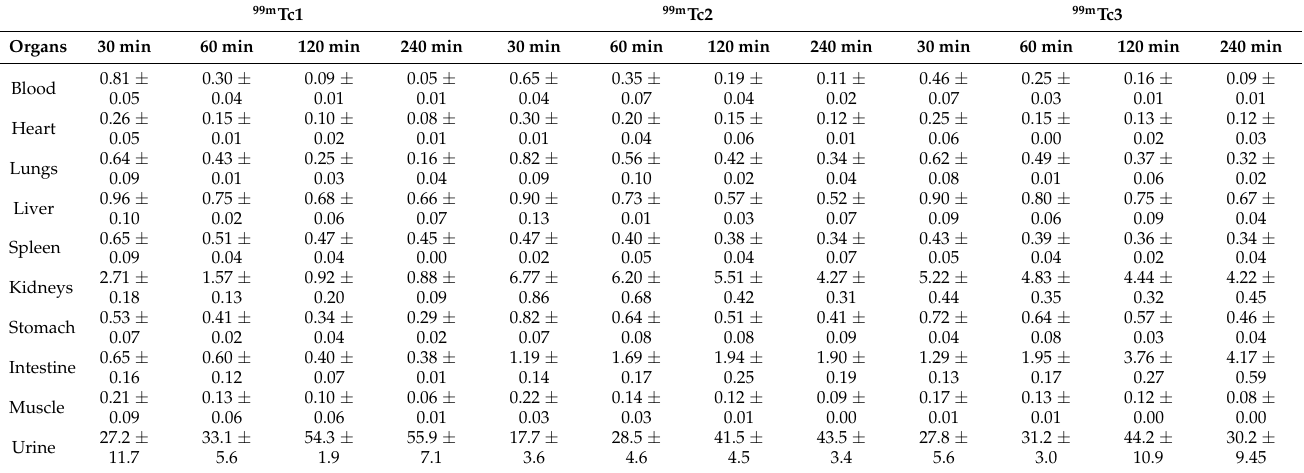
Table 3. Biodistribution studies of the [ 99m Tc(N)(H 2 NS-cRGDfK)(PNPn)] + complexes in healthy female Sprague Dawley rats ( n =